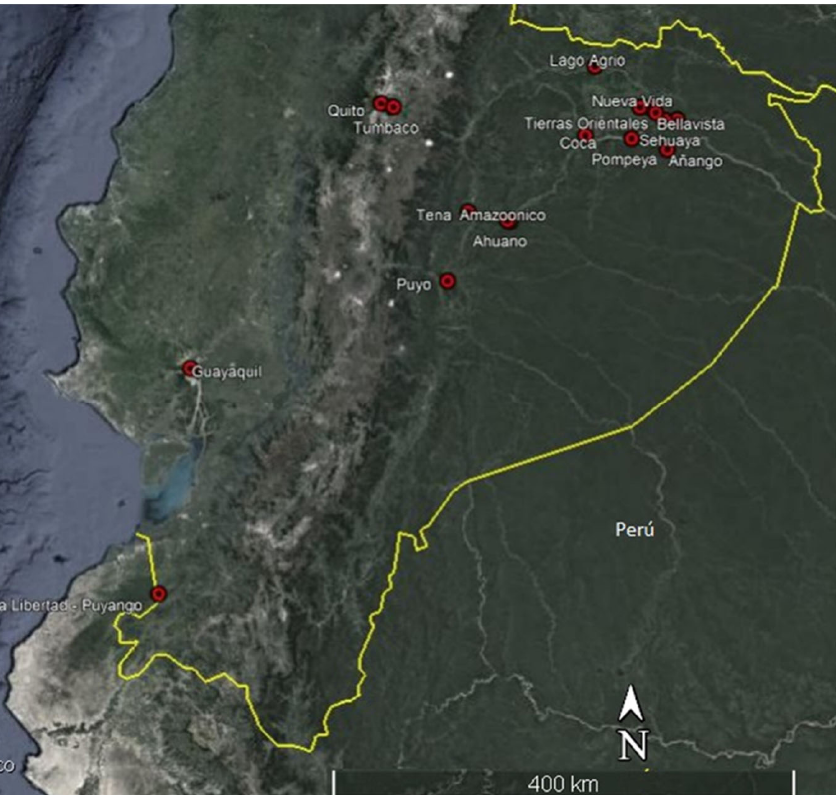
Figure 2. Sites where the environmental education journeys of the BMG project were carried out (2003–2020).